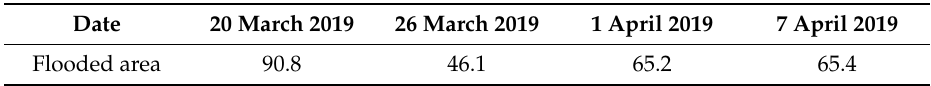
Table 6. Evolution of flooded area in Beira between 20 March and 7 April 2019 from Sentinel-1 NDR processing. Data in square